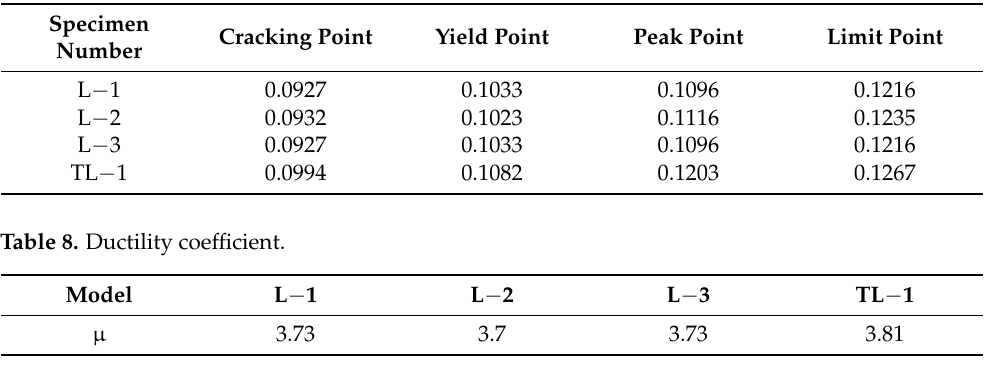
Figure 9. Skeleton Curve. Table 7. Equivalent viscosity coefficient.